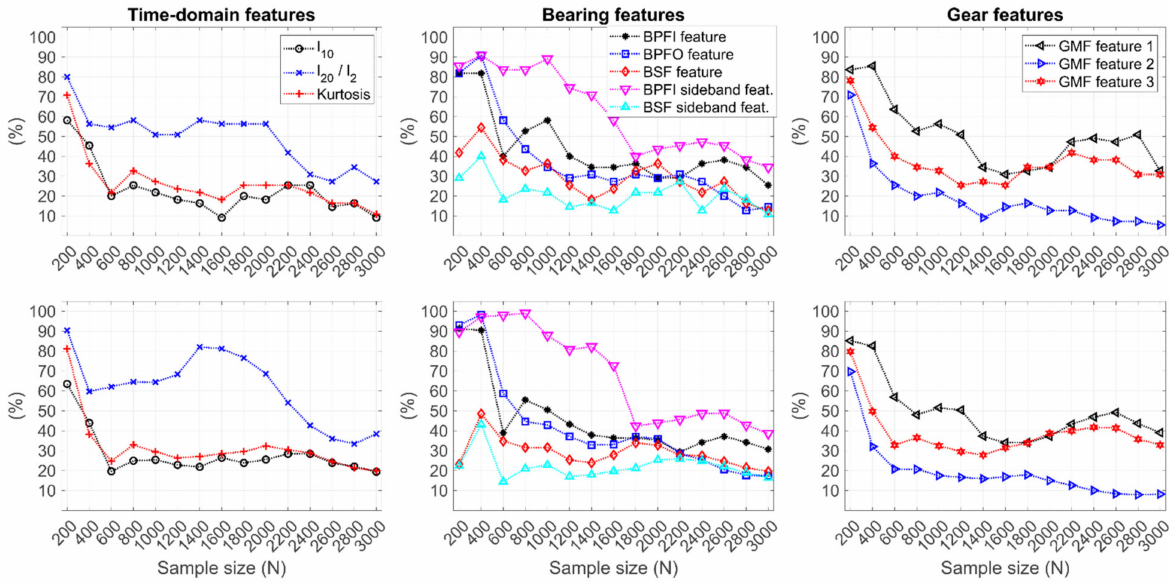
Figure A2. Percentage of acceptable training subsets for individual features. Dataset segmentation with ‘basic training subsets’ approach was used on top, whereas ‘adaptive training subsets’ approach was used